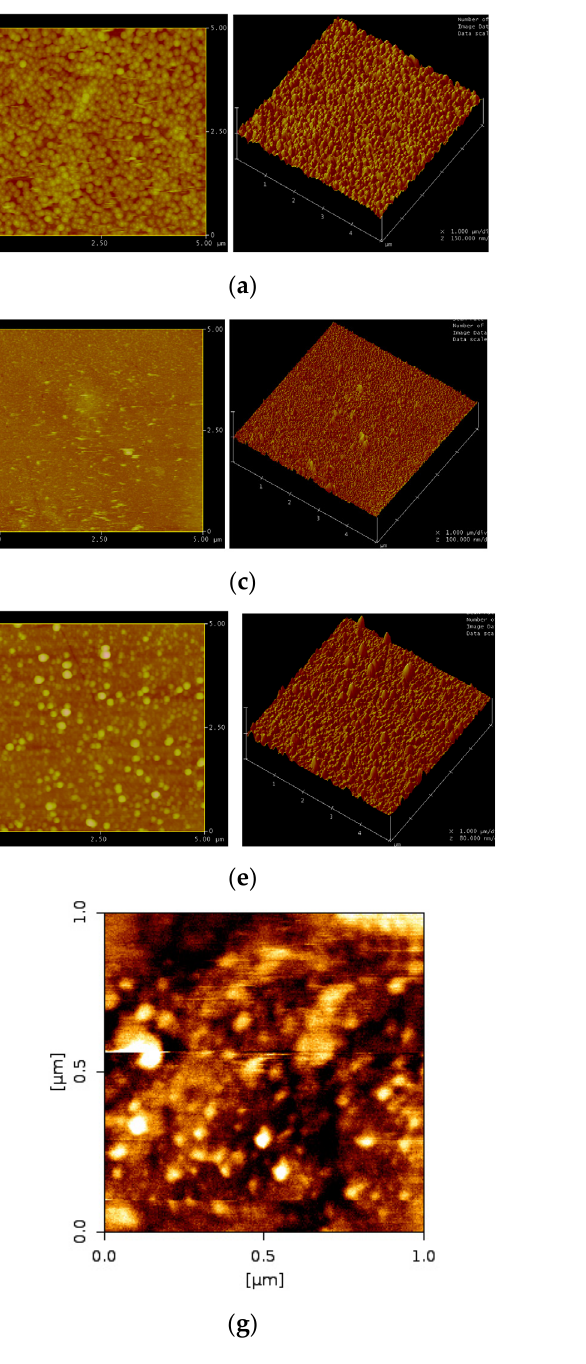
Figure 2. AFM images of each sample. ( a ) Sample 1, ( b ) sample 2, ( c ) sample 3, ( d ) sample 4, ( e ) sample 5, ( f ) sample 6, ( g ) substrate. The scan parameters are: scan size is 5.000 µ m, scan rate is 1.001 Hz, number of samples is 256, image date is height, x is 1.000 µ m/div and z is varied from 80 to 150